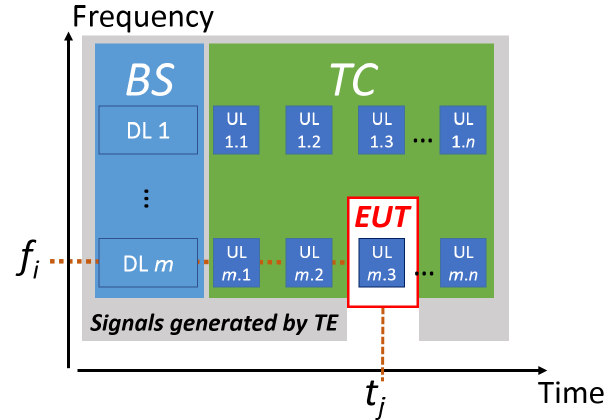
With combination CE and TC and protocol synchroniza-